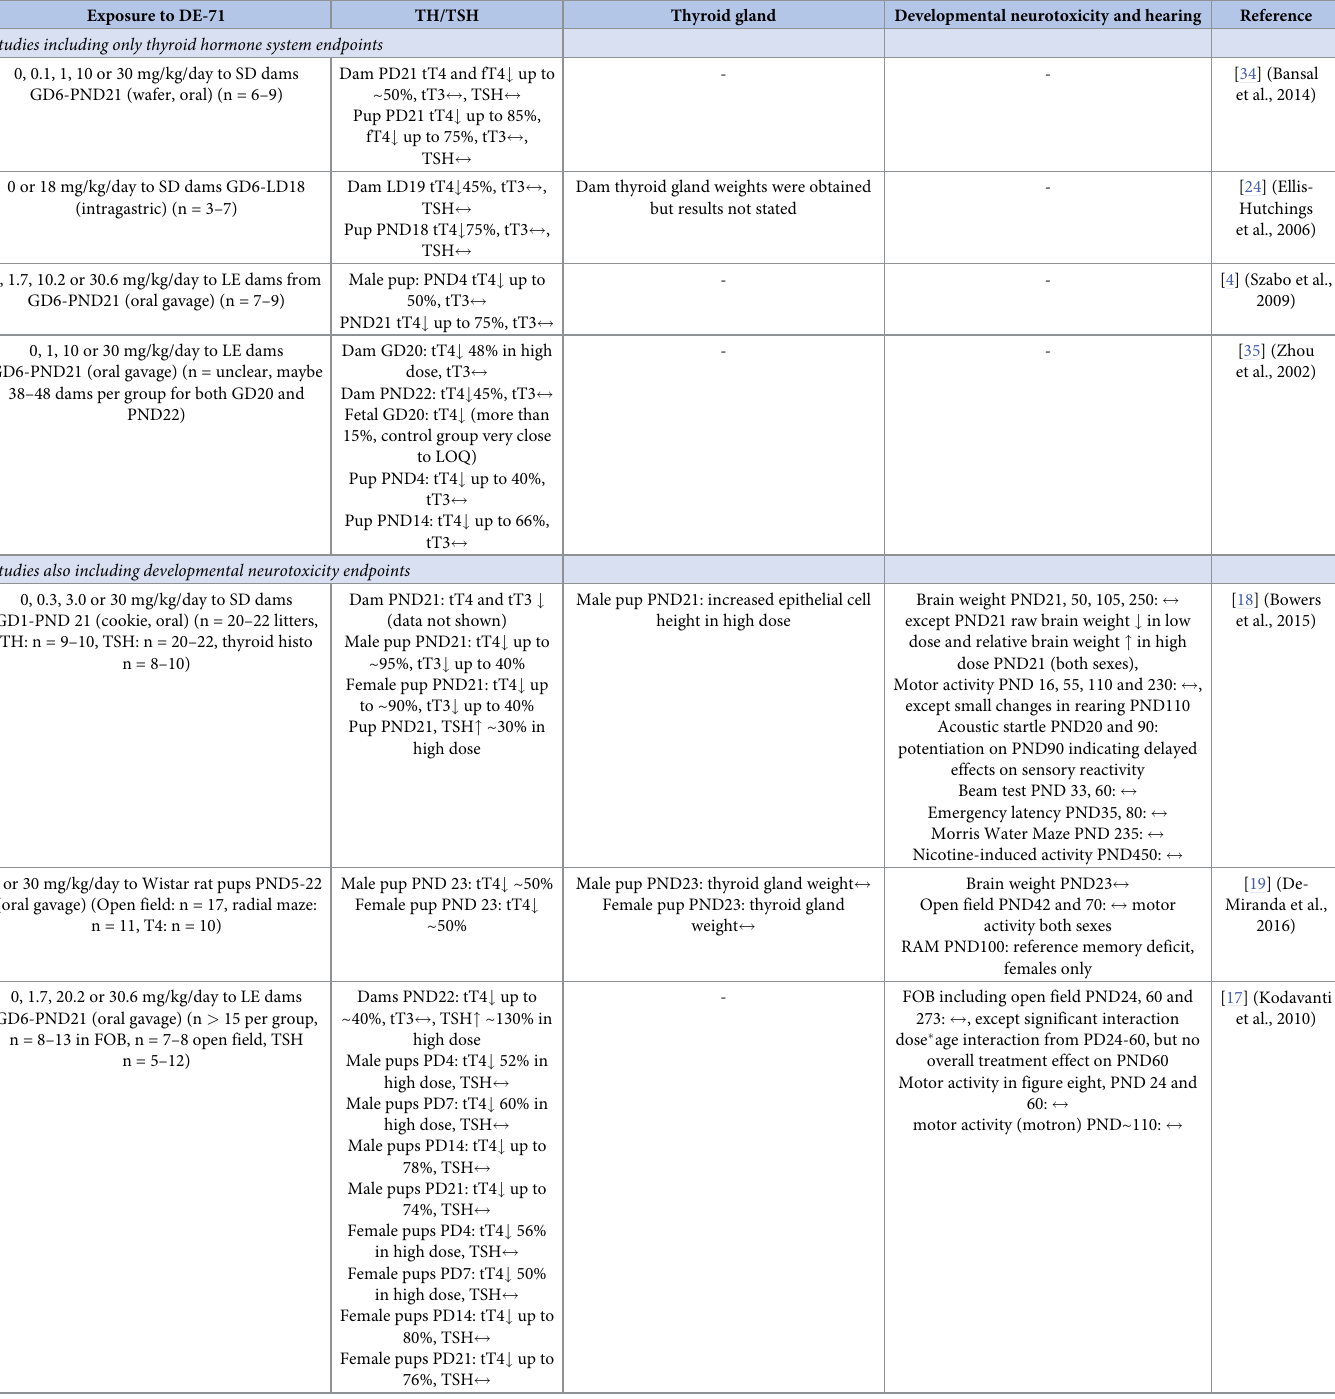
Table 1. Developmental DE-71 exposure studies of the thyroid hormone system and brain development in rats. Exposure to DE-71